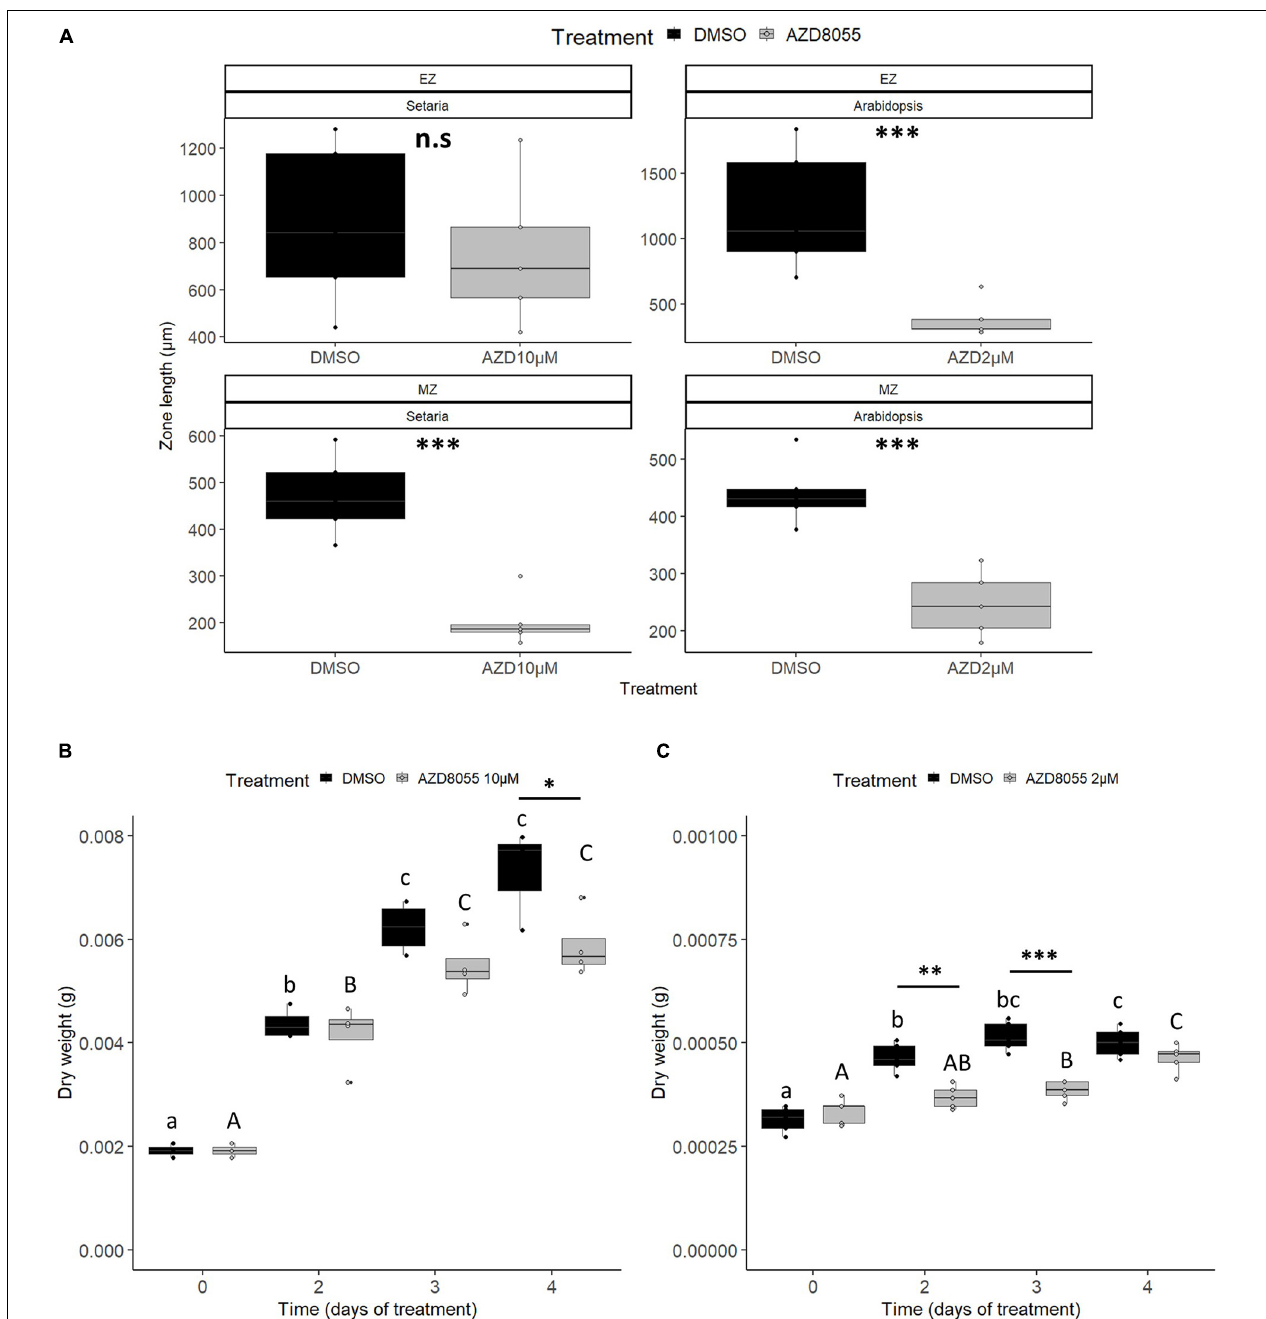
FIGURE 3 | AZD8055 severely impacts the growth of S. viridis and A. thaliana seedlings. Effect of AZD8055 on root and overall growth of S. viridis and A. thaliana . For all measurements, seedlings were grown hydroponically under 12 h photoperiod until specific and compatible developmental stages before application of DMSO 0.05% (control), 10 or 2 µ M AZD8055 ( S. viridis and A. thaliana , respectively). (A) Length of root EZ and MZ, expressed in cm. DW of S. viridis. (B) and A. thaliana. (C) Black and gray colors represent DMSO and AZD8055 treatments, respectively. Significant differences along time within the same treatment, using ANOVA, are indicated by letters ( P < 0.05), lower case for DMSO and capital letters for AZD8055-treated plants, and significant differences between treatments are indicated by asterisks (Student’s t -test): ∗ P < 0.05, ∗∗ P < 0.01, and ∗∗∗ P <